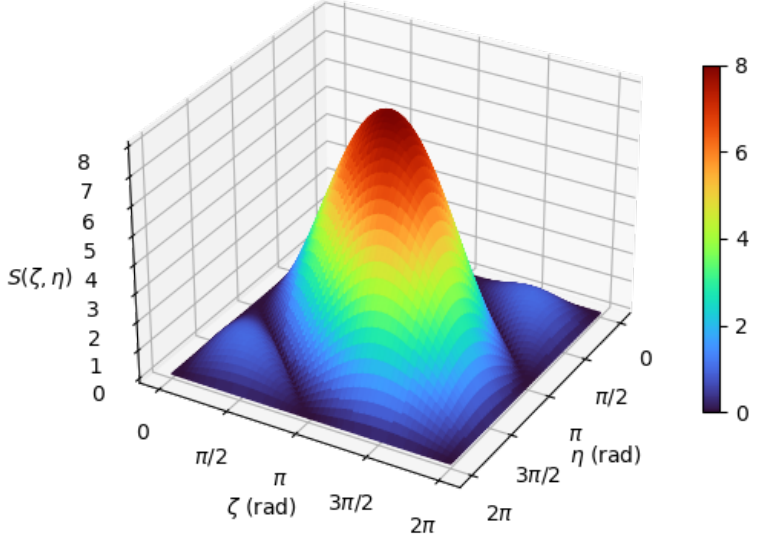
Figure 2. Plot of the S ( ζ , η ) function relative to the SMBHB candidate PKS 2131–021 and the MSP J2145–0750. The axes on the plane indicate the values assumed by the ζ and η variables defined in Equations (19) and (20), respectively, expressed in radians. The vertical axis and the color, described by the color bar, indicate the values assumed by S ( ζ , η ) , defined in Equation (21), dimensionless. Once t has been chosen to satisfy Equation (29), by setting, for example, n ζ ≡ 0, it is possible to define the function R ( θ ) ≡ R ( t 0 , θ ) , useful for verifying whether the angular separation θ between the MSP and the SMBHB candidate is such as to maximize the TRs. In × 10 − 8 Hz and T = 2024 + 16 this case, ω = 8.262 + 0.025 yr, therefore χ = 5274 + 58 , and at the − 0.025 − 65 − 186